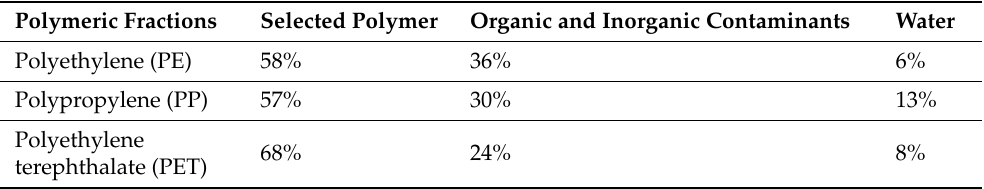
Table 1. Weight percent of plastic, moisture and solid contaminants in each batch sorted by the NIR separator.